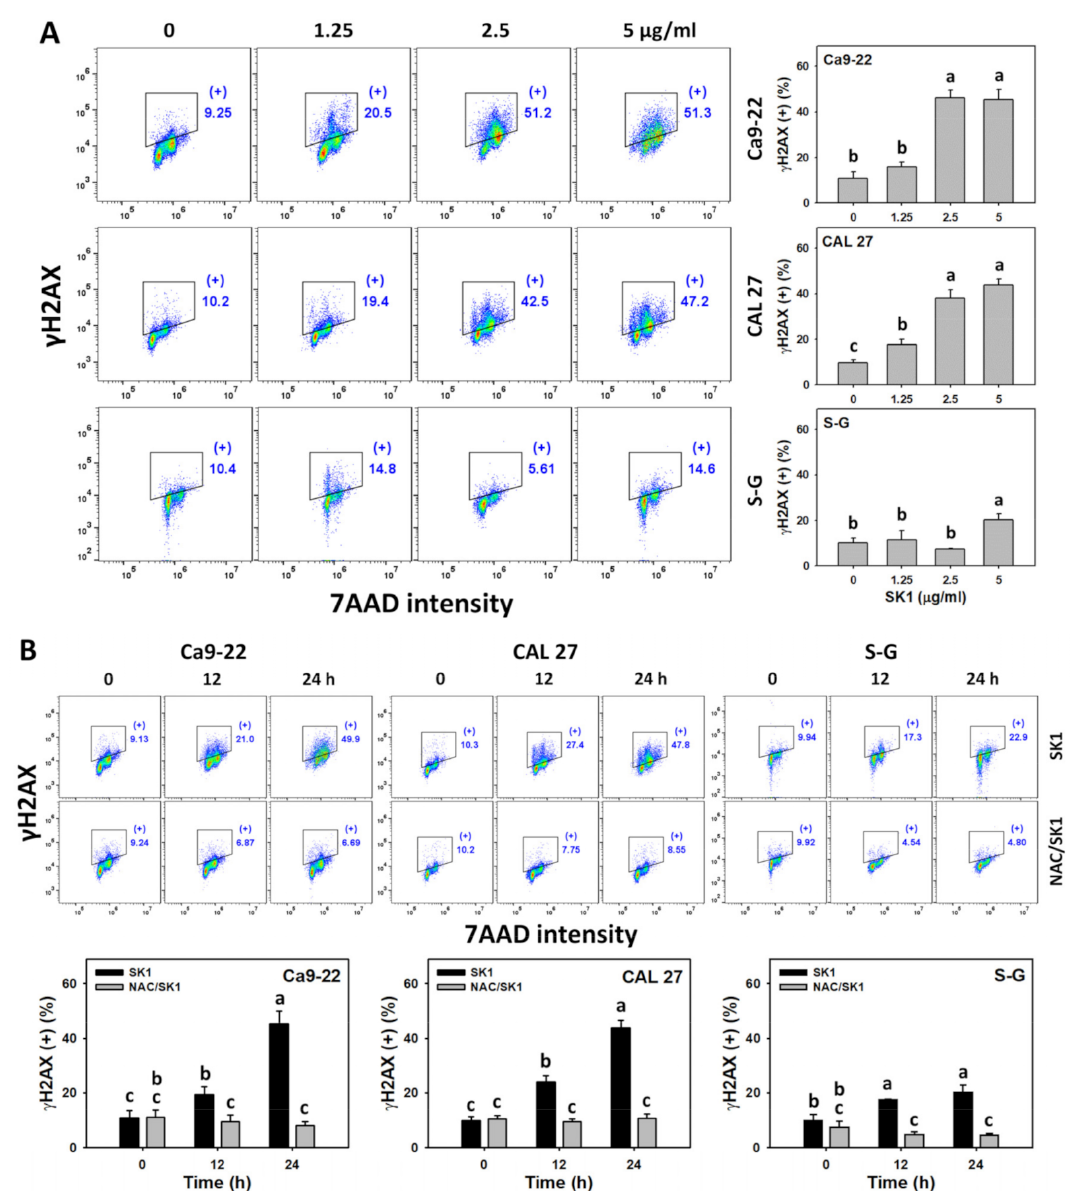
Figure 9. DNA damage effects ( γ H2AX) of SK1. ( A ) γ H2AX assays of SK1. Non-malignant (S–G) and oral cancer (Ca9-22 and CAL 27) cells were treated with SK1 (0 (0.1% DMSO in medium), 1.25, 2.5, and 5 µ g/mL) for 24 h. ( B ) γ H2AX assays of NAC/SK1. NAC/SK1 indicated that cells were pretreated with NAC and posttreated with SK1 5 µ g/mL for 0, 12, and 24 h. (+) inserted at the histogram is counted for the percentage of γ H2AX (+)(%). Data, mean ± SD ( n = 3). Statistical software provided non-overlapping low-case letters indicate significant results for multi-comparison ( p <